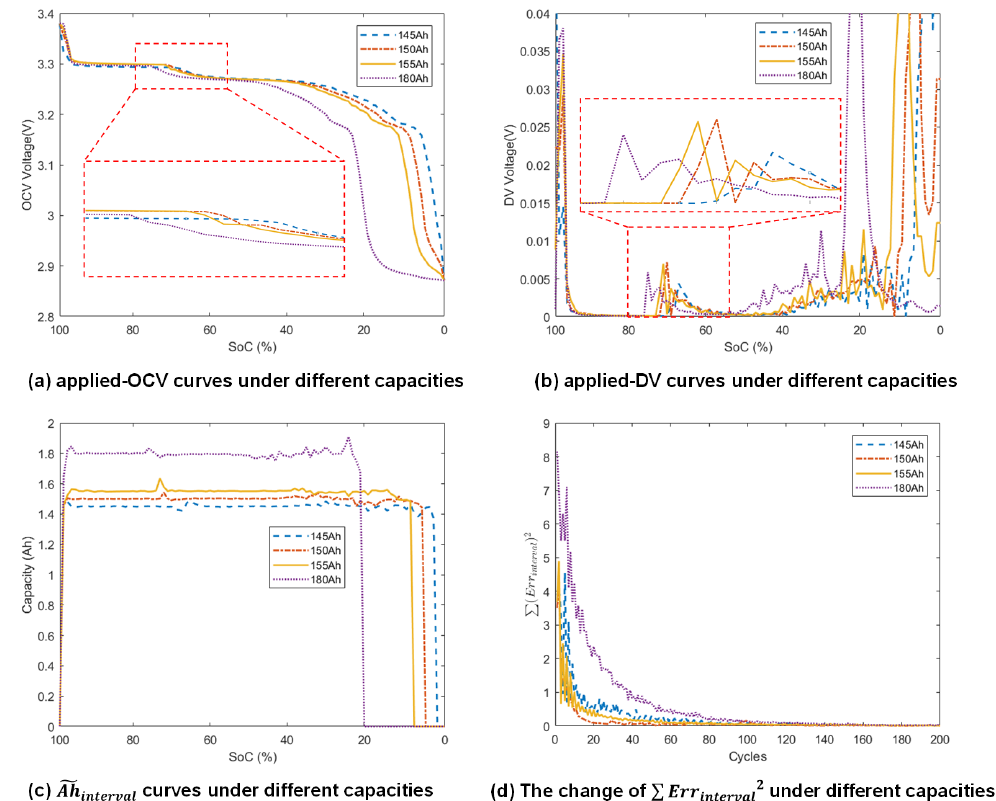
Figure 13. Experimental results under different battery capacities .